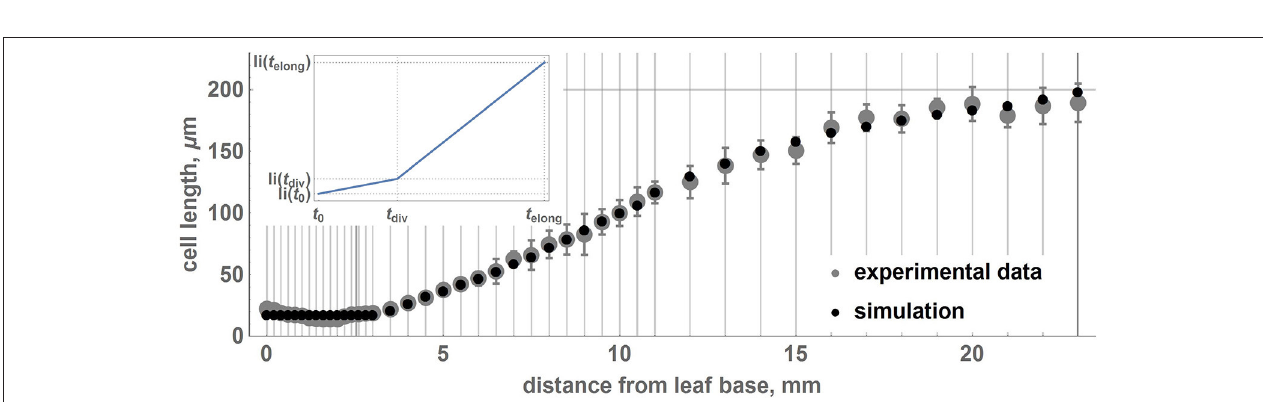
FIGURE 2 | Numerical experiment for the growth of the isolated cell with the adopted parameters. (A) Growth functions for isosmotic, visible, and relaxed lengths. (B) The dynamics of osmotic and turgor pressures.